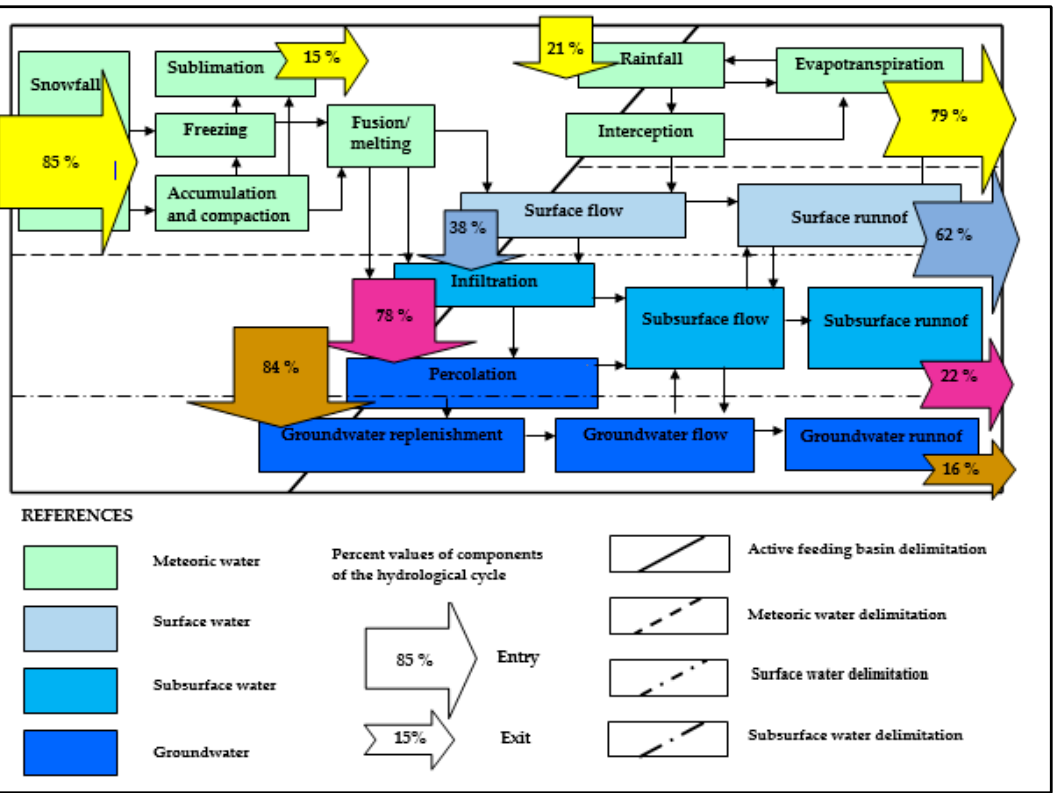
Figure 2. Main water balance components and physical processes in the Mendoza River basin.